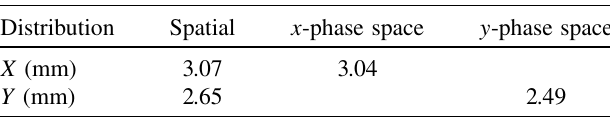
TABLE III. Experimental beam parameters. Beam energy